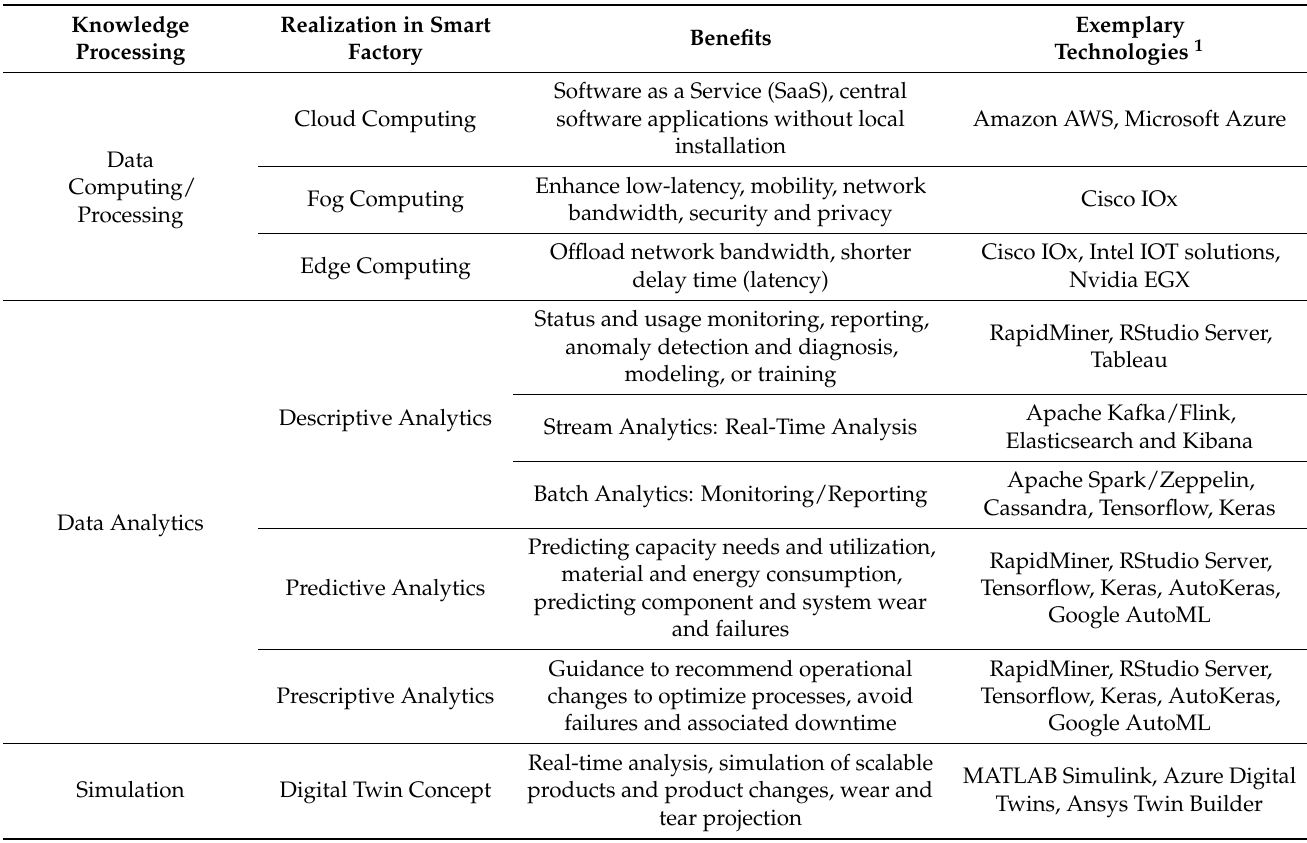
Table 1. Overview of Knowledge Integration on a Technological Level.